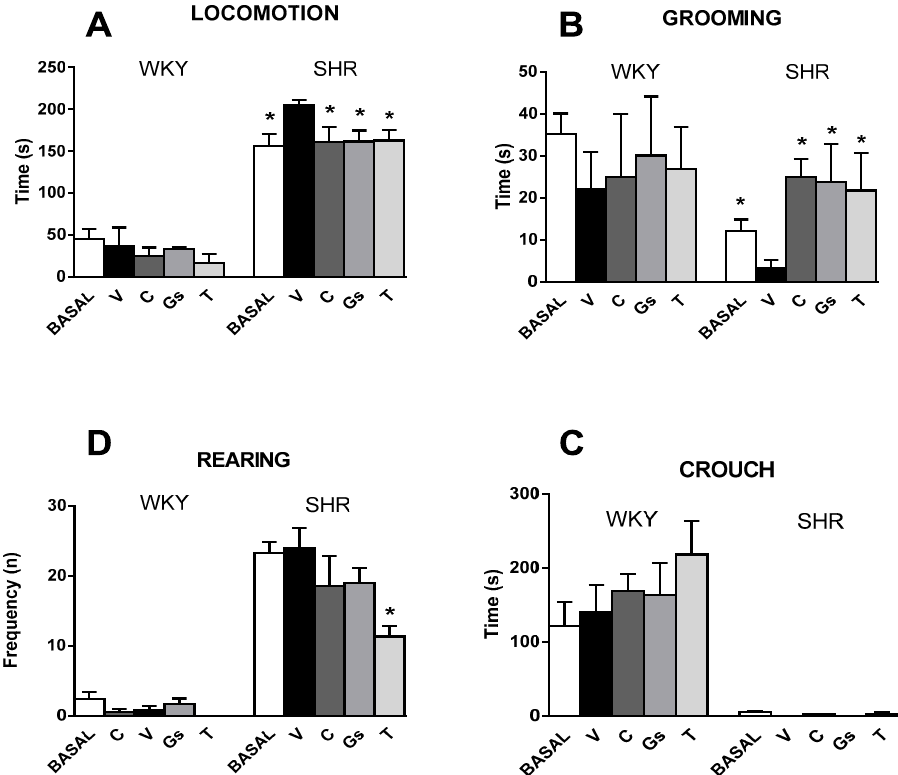
Figure 3. Time duration (s) of locomotion ( A ), grooming ( B ) and crouch ( C ) and frequency of rearing ( D ). SHRs (S) and WKY (W) rats were treated for four weeks with vehicle (V), captopril (C) (50 mg/kg), tomatine (T) (8 mg/kg) or tomato gel/serum (Gs) (400 mg/kg). Different behaviors were assessed at day 0 (before the treatment, BASAL) and at the end of any treatment. Values represent mean ± SEM; * p < 0.05 vs. SHR V; no significant differences were observed in the WKY groups (ANOVA followed by Bonferroni).